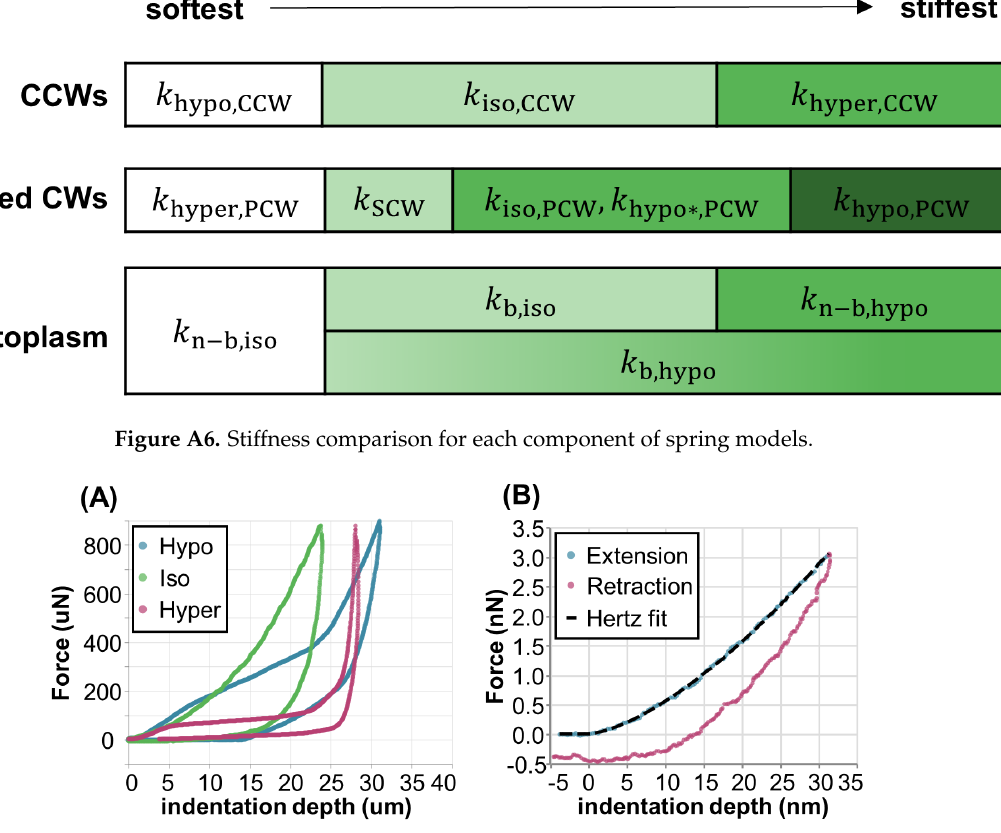
Figure A7. Example force-indentation data for ( A ) micro-compression experiment on three different cells in each of the three osmotic treatments; hypotonic, isotonic, and hypertonic, and ( B ) AFM experiment with extension (blue line) and retraction (pink line) data with Hertz fit (dash line)